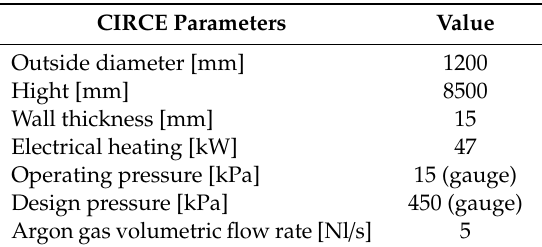
Table 1. Pool vessel parameters.